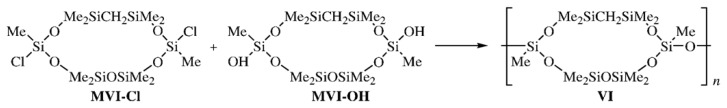
Synthesis of CL PMCS VI.